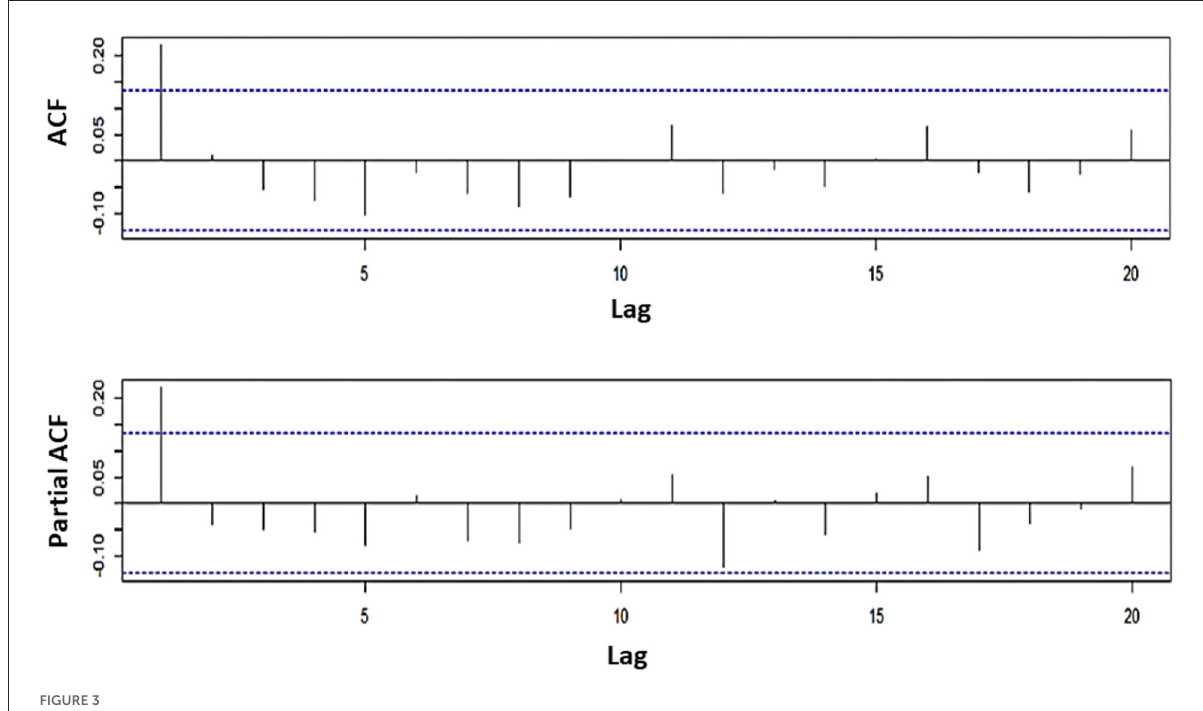
FIGURE3 ACF and PACF plots of WTI oil data.